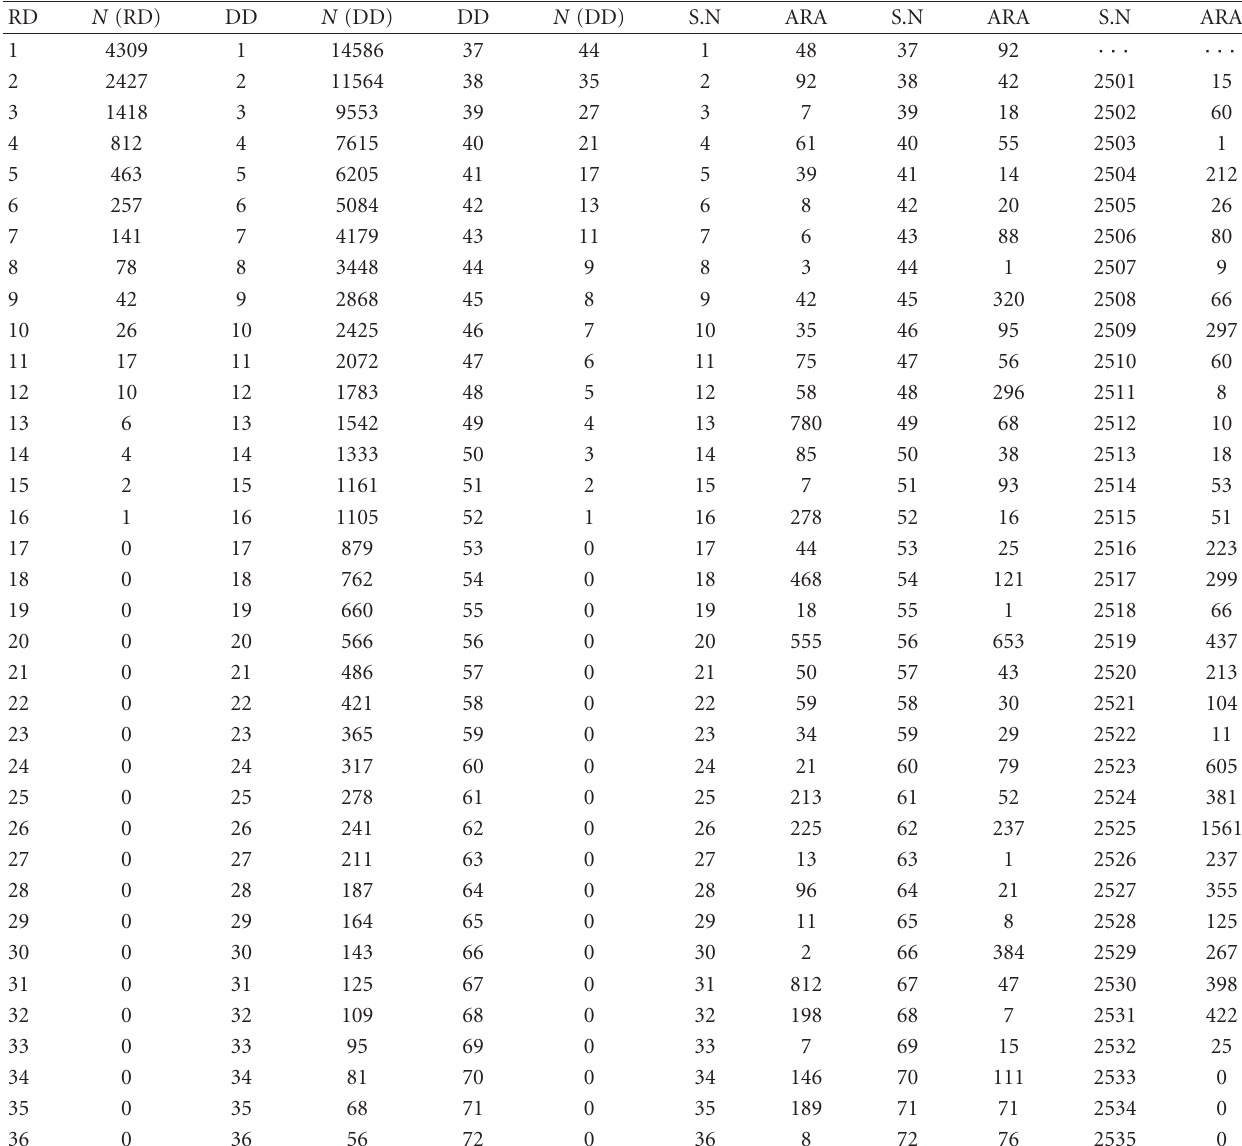
Table 3: Days of RD and DD; ARA (in 0.1 mm) per rain